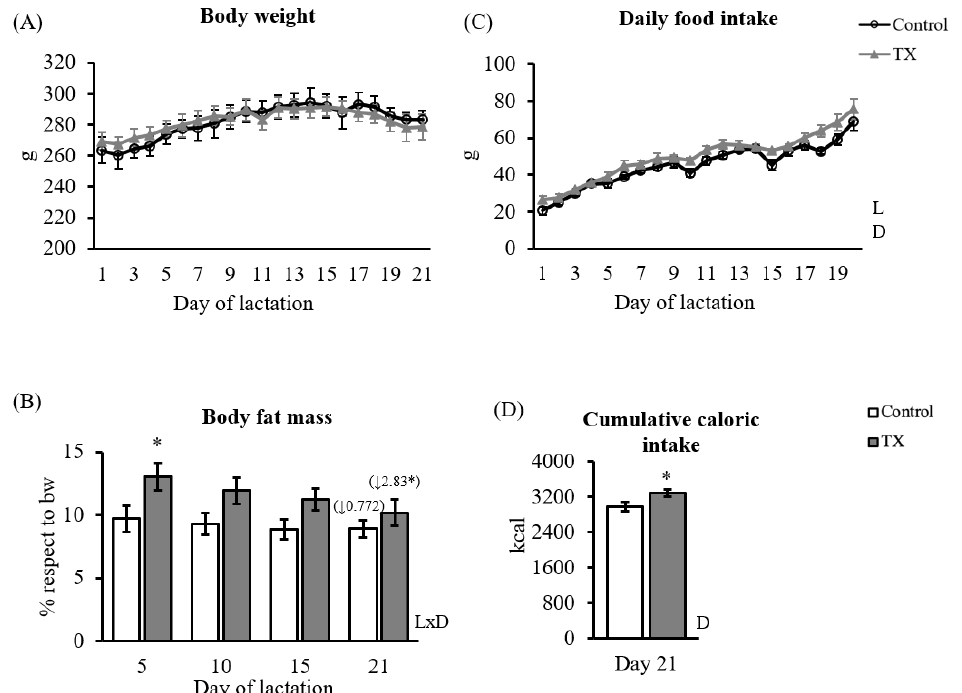
Figure 1. Body weight and intake data of dams throughout lactation: body weight evolution ( A ), body fat mass ( B ), daily intake evolution ( C ), and cumulative intake at the end of lactation ( D ). Data are mean ± SEM ( n = 7). ( B ) The percentage of body fat decrease throughout lactation is indicated in brackets with a down arrow for each group. Statistics: A repeated measures ANOVA was carried out to study the effect of maternal diet and day of lactation: LxD, the interaction between lactation day and TX diet. Single comparisons between groups were performed by Student’s t -test: *, different from controls. Threshold significance was set at p ≤ 0.05 for all tests.